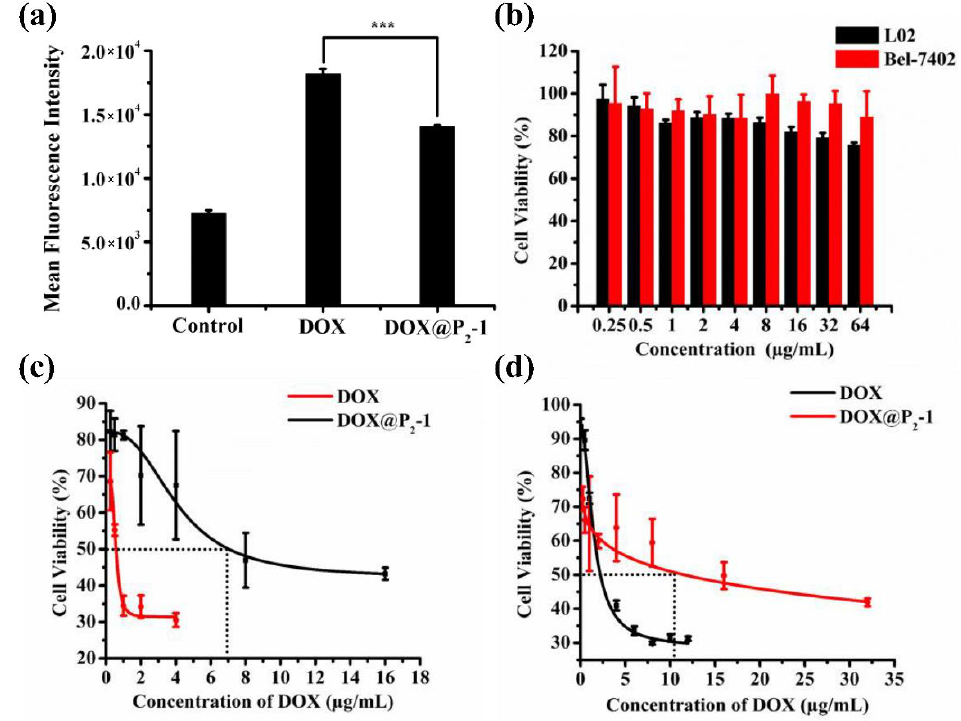
Figure 10. Quantitative measurements of the average fluorescence intensities of free DOX and DOX@P 2 -1 by flow cytometry in Bel-7402 cells ( n = 3, *** p < 0.001) ( a ); In vitro cytotoxicity of P 2 micelles in L02 cells and Bel-7402 ( b ) as well as DOX, DOX@P 2 -1 in L02 cells ( c ), and Bel-7402 cells ( d ).